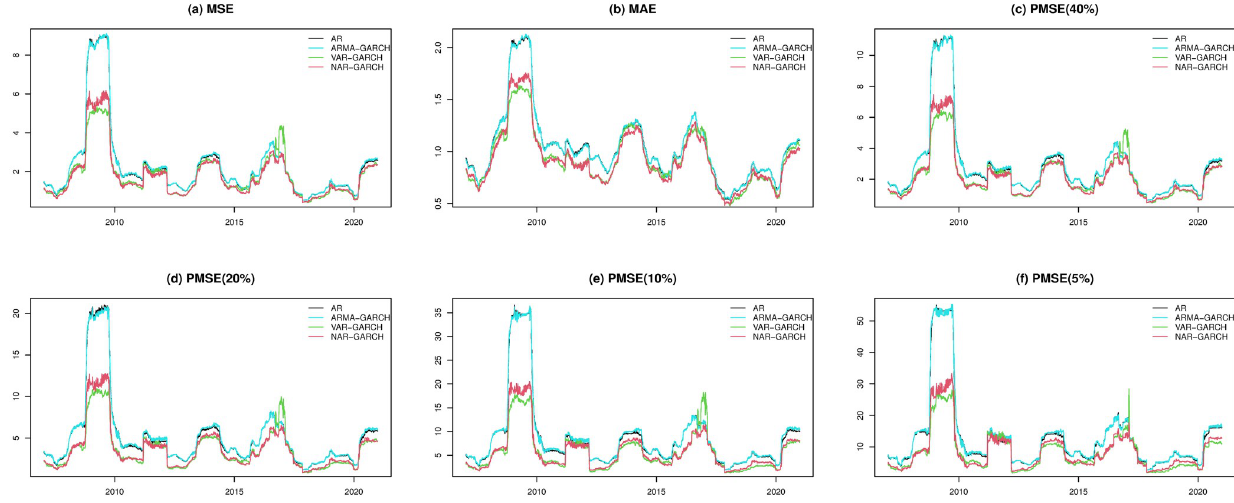
Fig 3. The fitted performances of the 4 models for the N225 index.